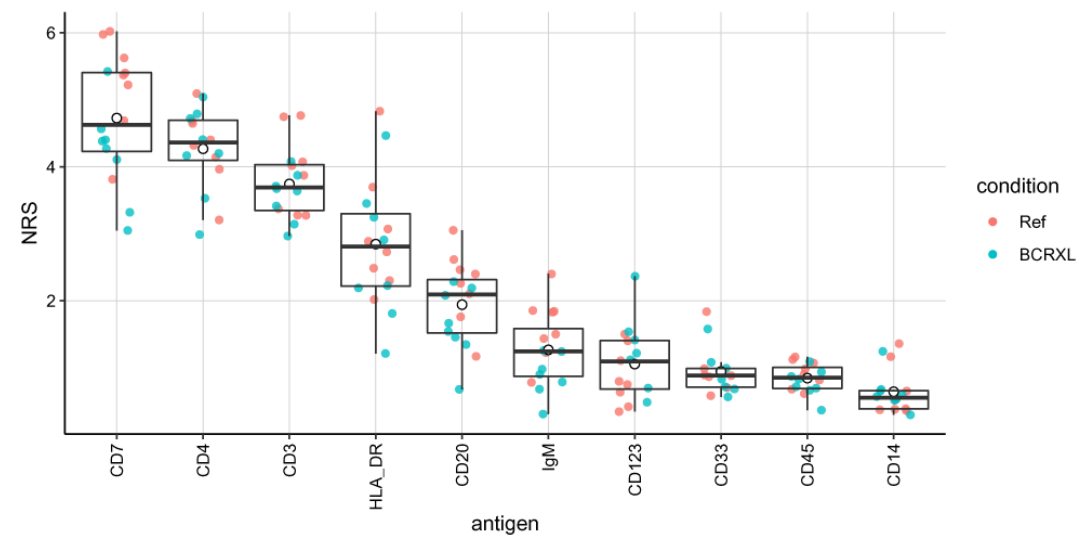
Figure 5. Non-redundancy scores for each of the 10 lineage markers and all samples in the PBMC dataset. The full points represent the per-sample NR scores (colored by experimental conditions), while empty black circles indicate the mean NR scores from all the samples. Markers on the x-axis are sorted according to the decreasing average NRS.